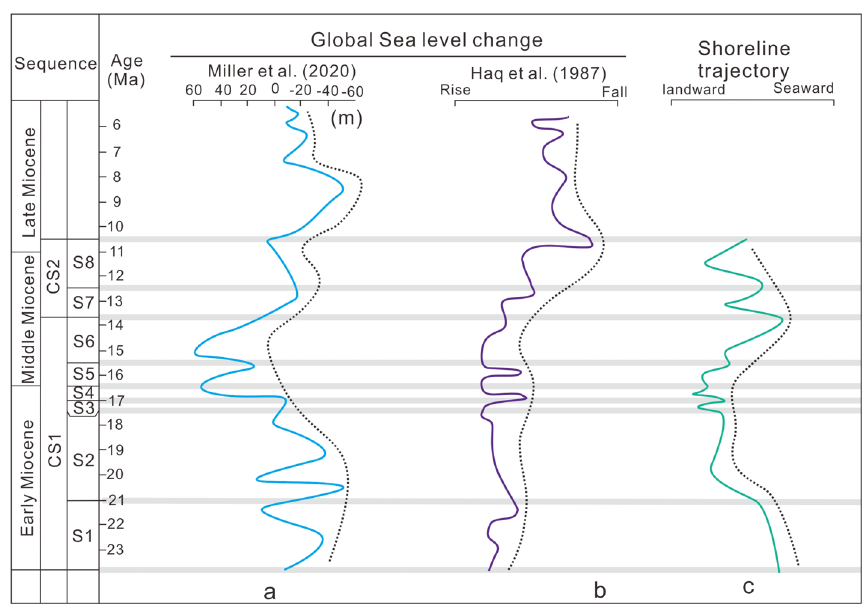
Figure 11. The comparison of shoreline trajectory and global sea level change in the Early-Mid Miocene on the northern Pearl River Mouth basin. Two typical global sea level curves 51,52 are listed in the figure and they are partly related to the changes of shoreline trajectory in the study area. The gray lines were the sequence boundary of each